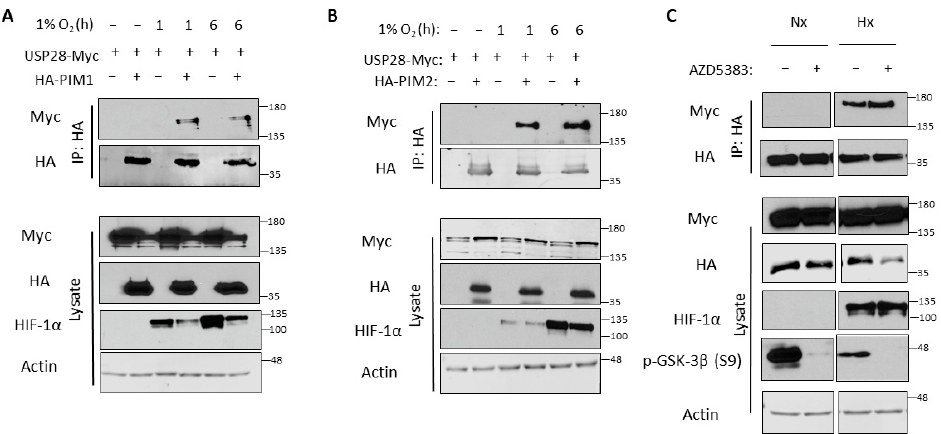
Figure 4. USP28 binds to PIM1/2 preferentially in hypoxia. 293T cells were co-transfected with USP28-Myc and HA-PIM1 ( A ) or HA-PIM2 ( B ) and cultured in normoxia or hypoxia for 1 or 6 h. HA-PIM1/2 were immunoprecipitated, and immunoprecipitated and input lysates were used for western blotting. Cells transfected with USP28-Myc alone were used as a negative control. ( C ) 293T cells were co-transfected with HA-PIM2 and USP28-Myc, treated with vehicle or an Akt inhibitor (AZD5383), and cultured in normoxia or hypoxia for 6 h. HA-PIM2 was immunoprecipitated, and immunoprecipitated and input lysates were used for western blotting.